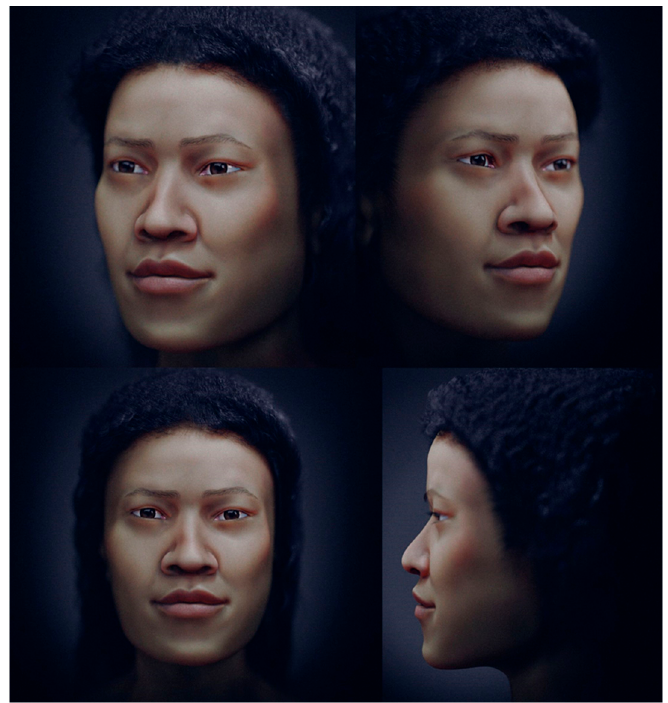
Figure 6. The final image of GKph2017.